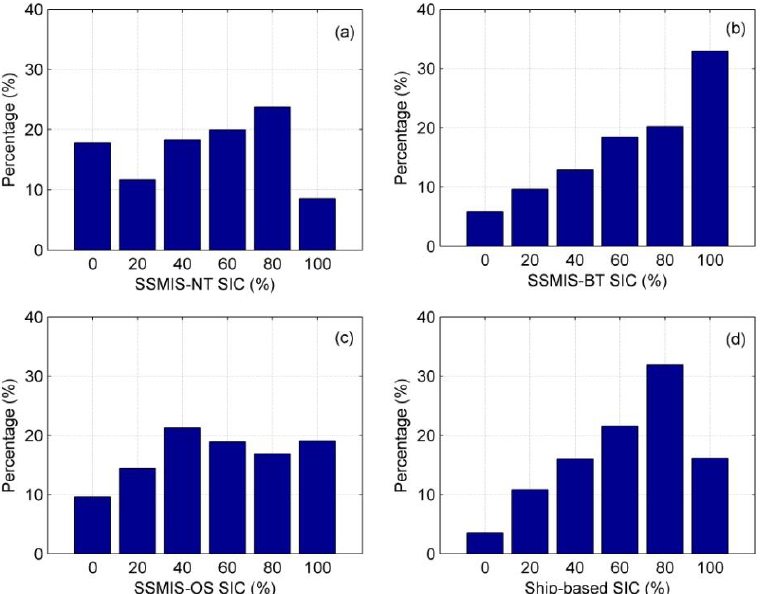
Figure 7. Histogram for the ( a ) SSMIS-NT, ( b ) SSMIS-BT, and ( c ) SSMIS-OS and ( d ) ship-based SIC on a pan-Arctic daily mean scale.